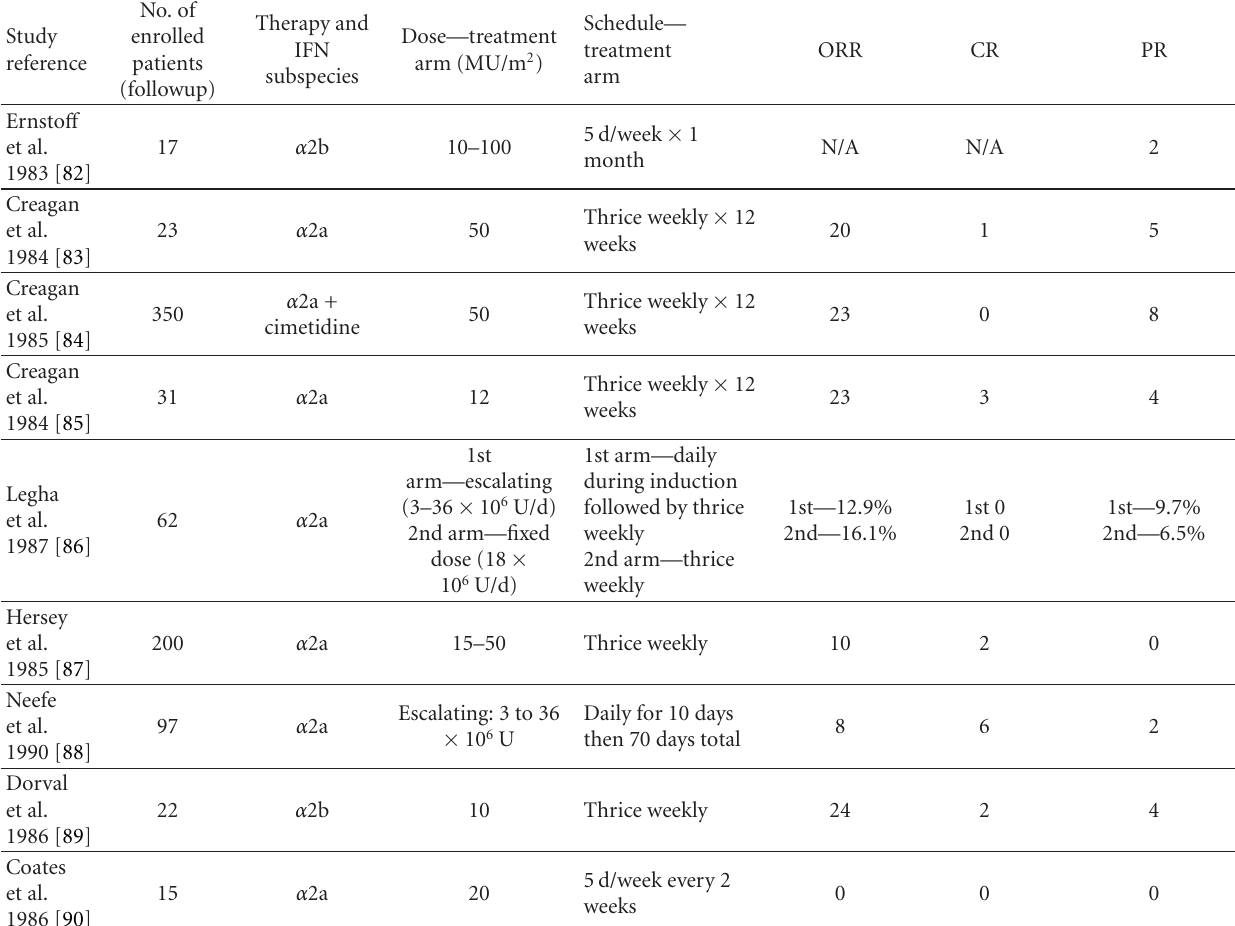
Table 1: Phase II trials of IFN- α for metastatic